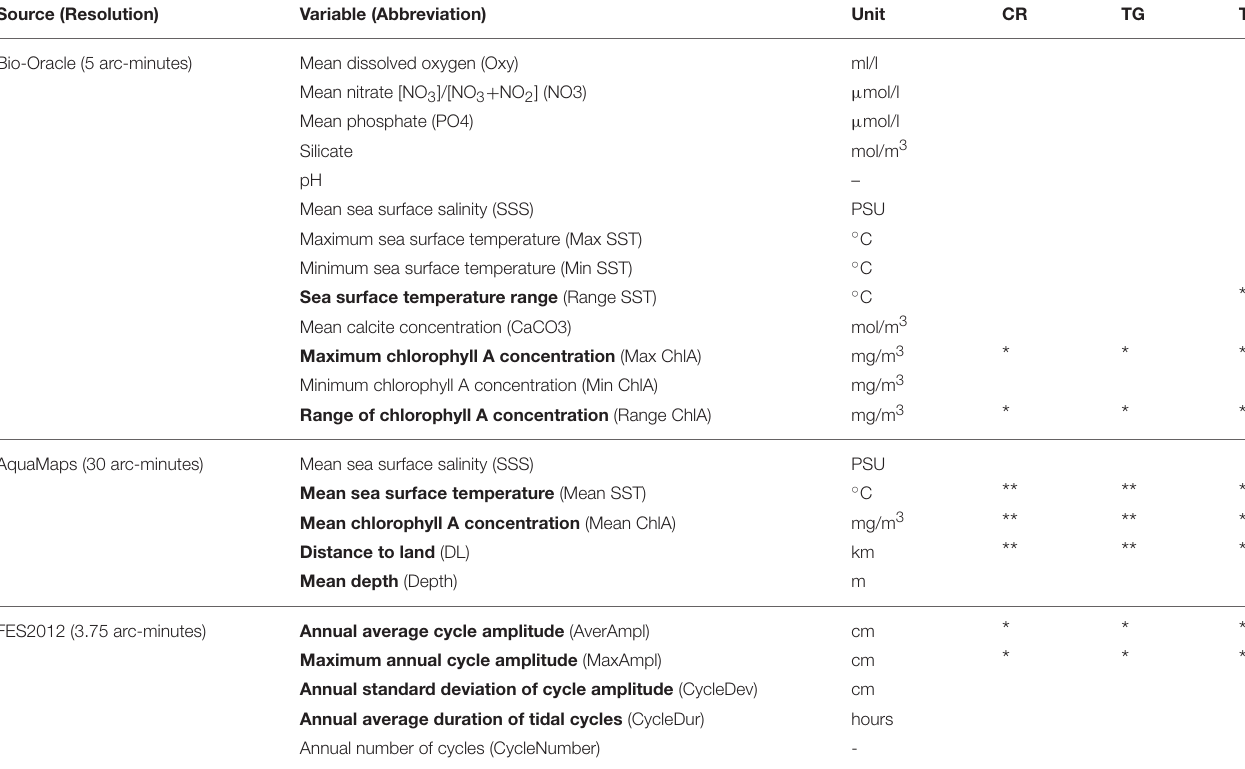
TABLE 2 | Environmental variables investigated for ecological niche modeling of the three Asian horseshoe crabs. Source (Resolution) Variable (Abbreviation) Bio-Oracle (5